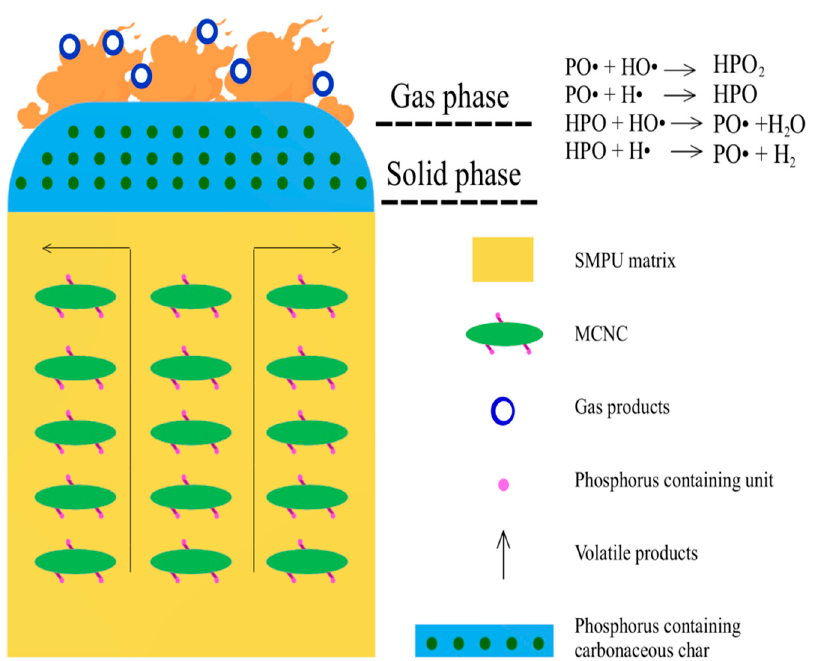
Figure 18. Schematic representation of the possible flame-retardant mechanism of composite. Adapted from [130].